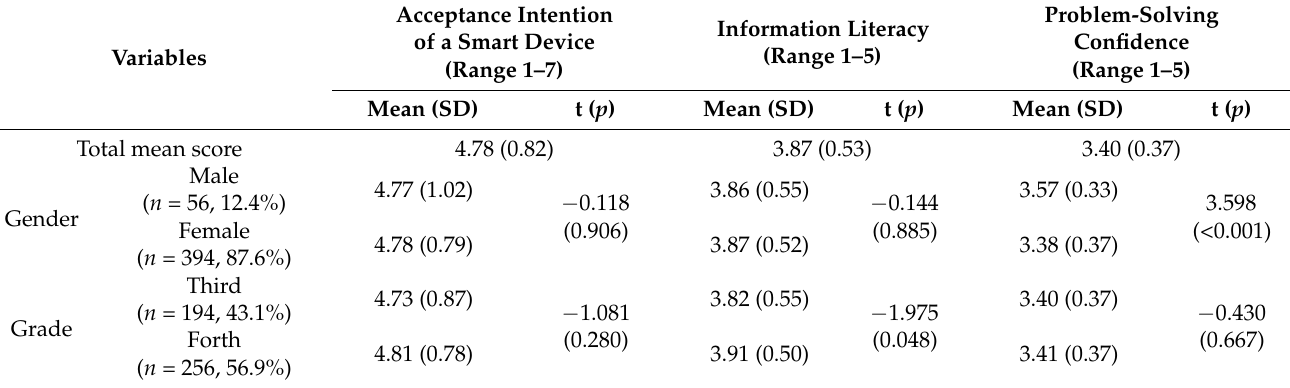
Table 1. Scores of acceptance intention of a smart device, information literacy, and problem-solving confidence.